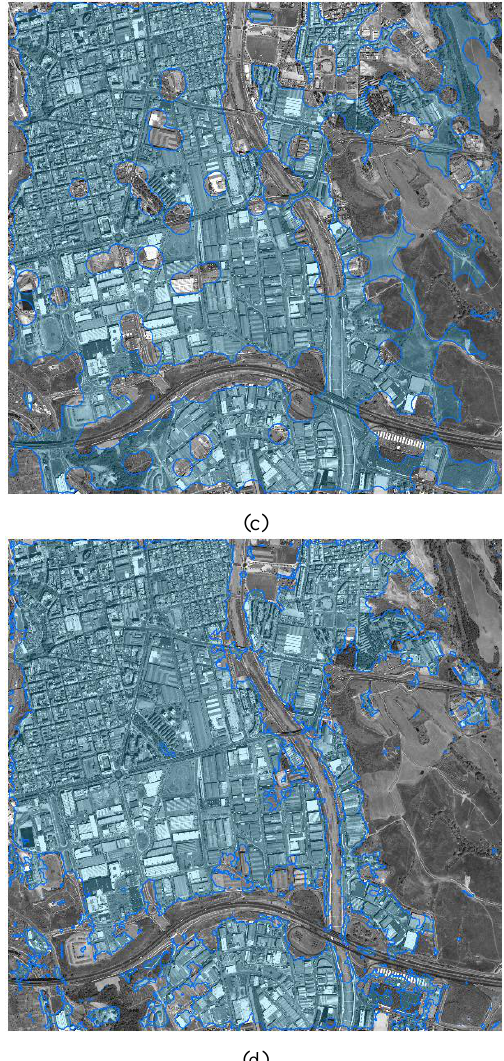
Figure 3. Results for Stereo pair 1 obtained using different built-up area detection methods. (a) Pantex method. (b) Gabor method. (c) nDSM method. (d) Our